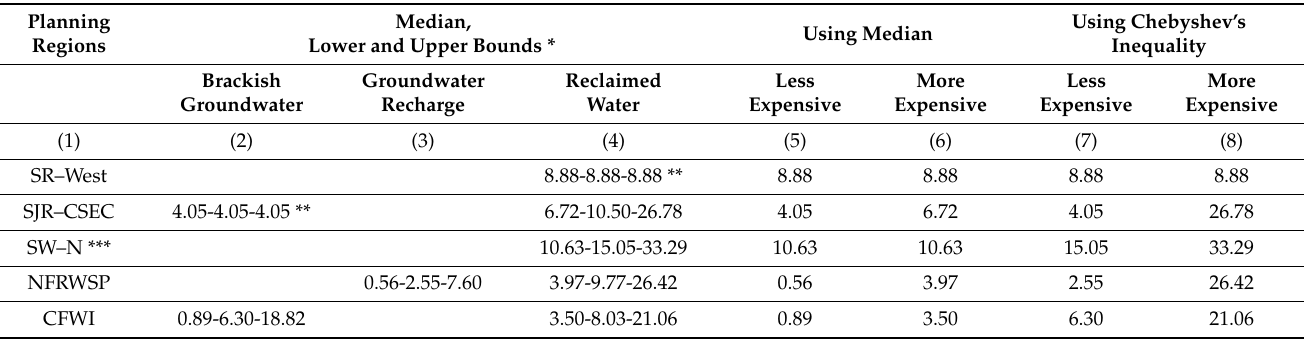
Table 4. Estimated Project Expenditures per Unit of Capacity (million USD 2021 per